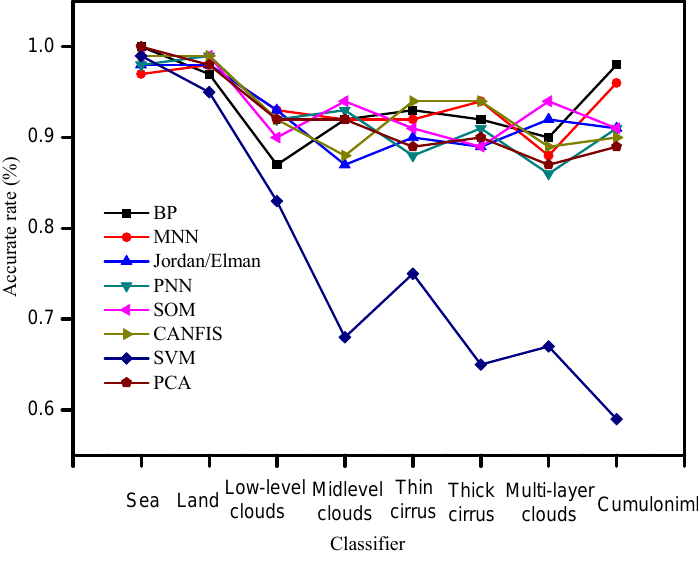
Figure 4. The accuracy rate of the eight cloud classifiers for the test